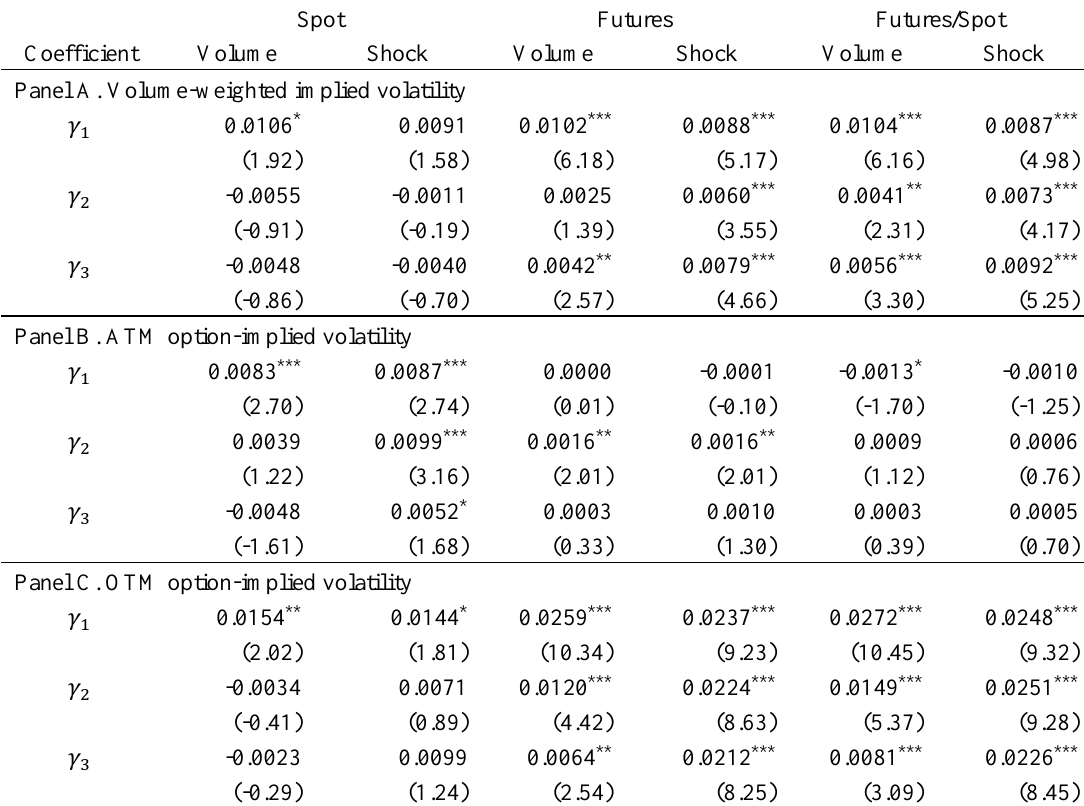
Table 4 : Effects of trading volumes and volume shocks on option-implied volatility